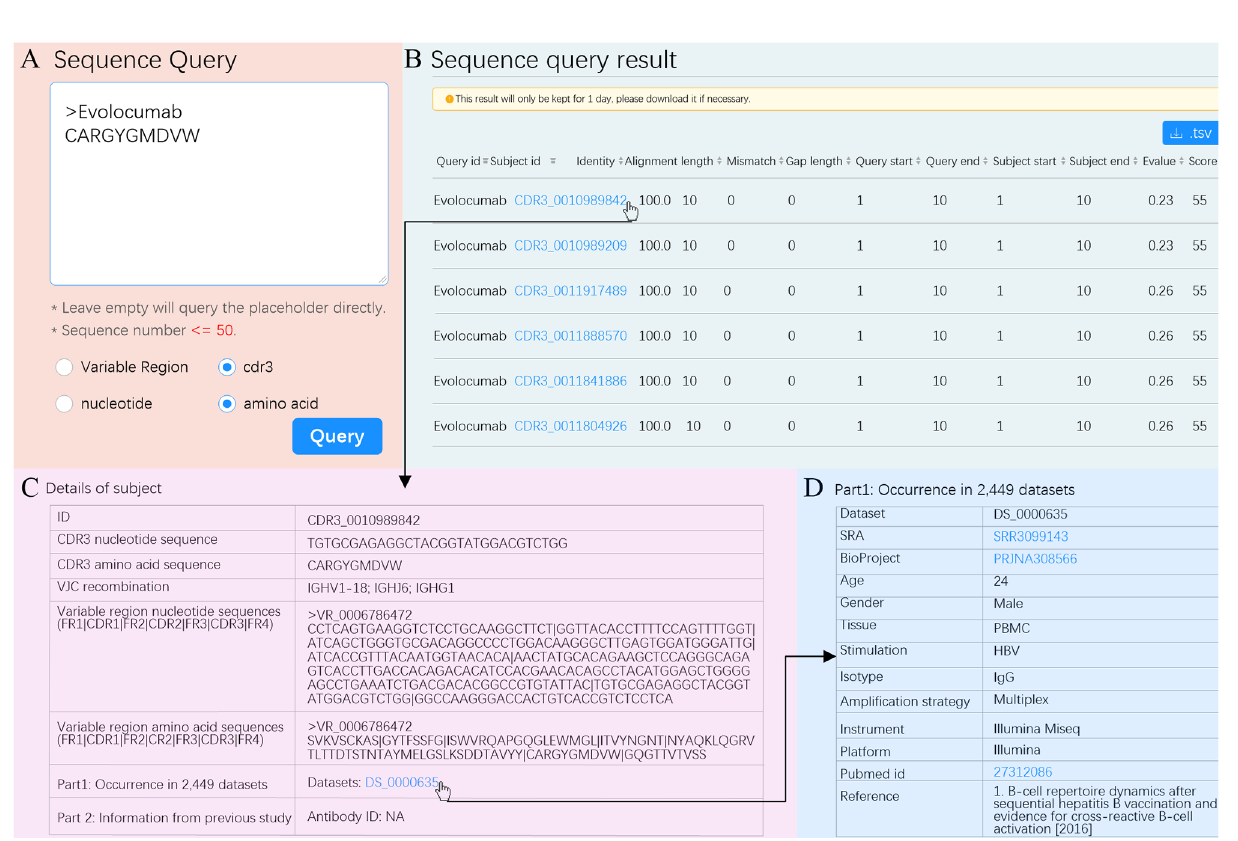
FIGURE 5 | “ Sequence Query ” schematic. (A) Input options for “ Sequence Query ” . Selected options are marked with blue dots. (B) Sequence query result. The subject ID fi lled in blue is a hyperlink and can be clicked to see details. Hit sequences can be sorted according to any column by clicking the marker at the end of each column. (C) Details for subject CDR3_0010989842. (D) Metadata of dataset with such a subject. The accession number of SRA, BioProject, and pubmed id can be clicked to visit their original